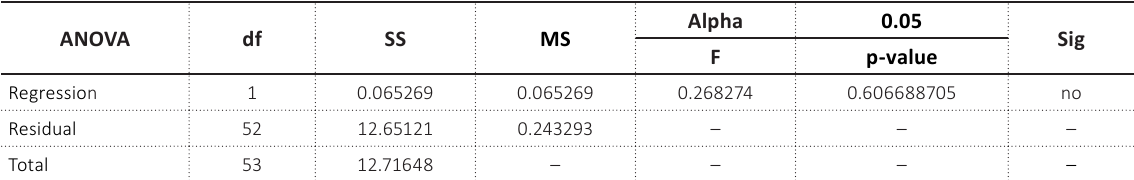
Source: Research